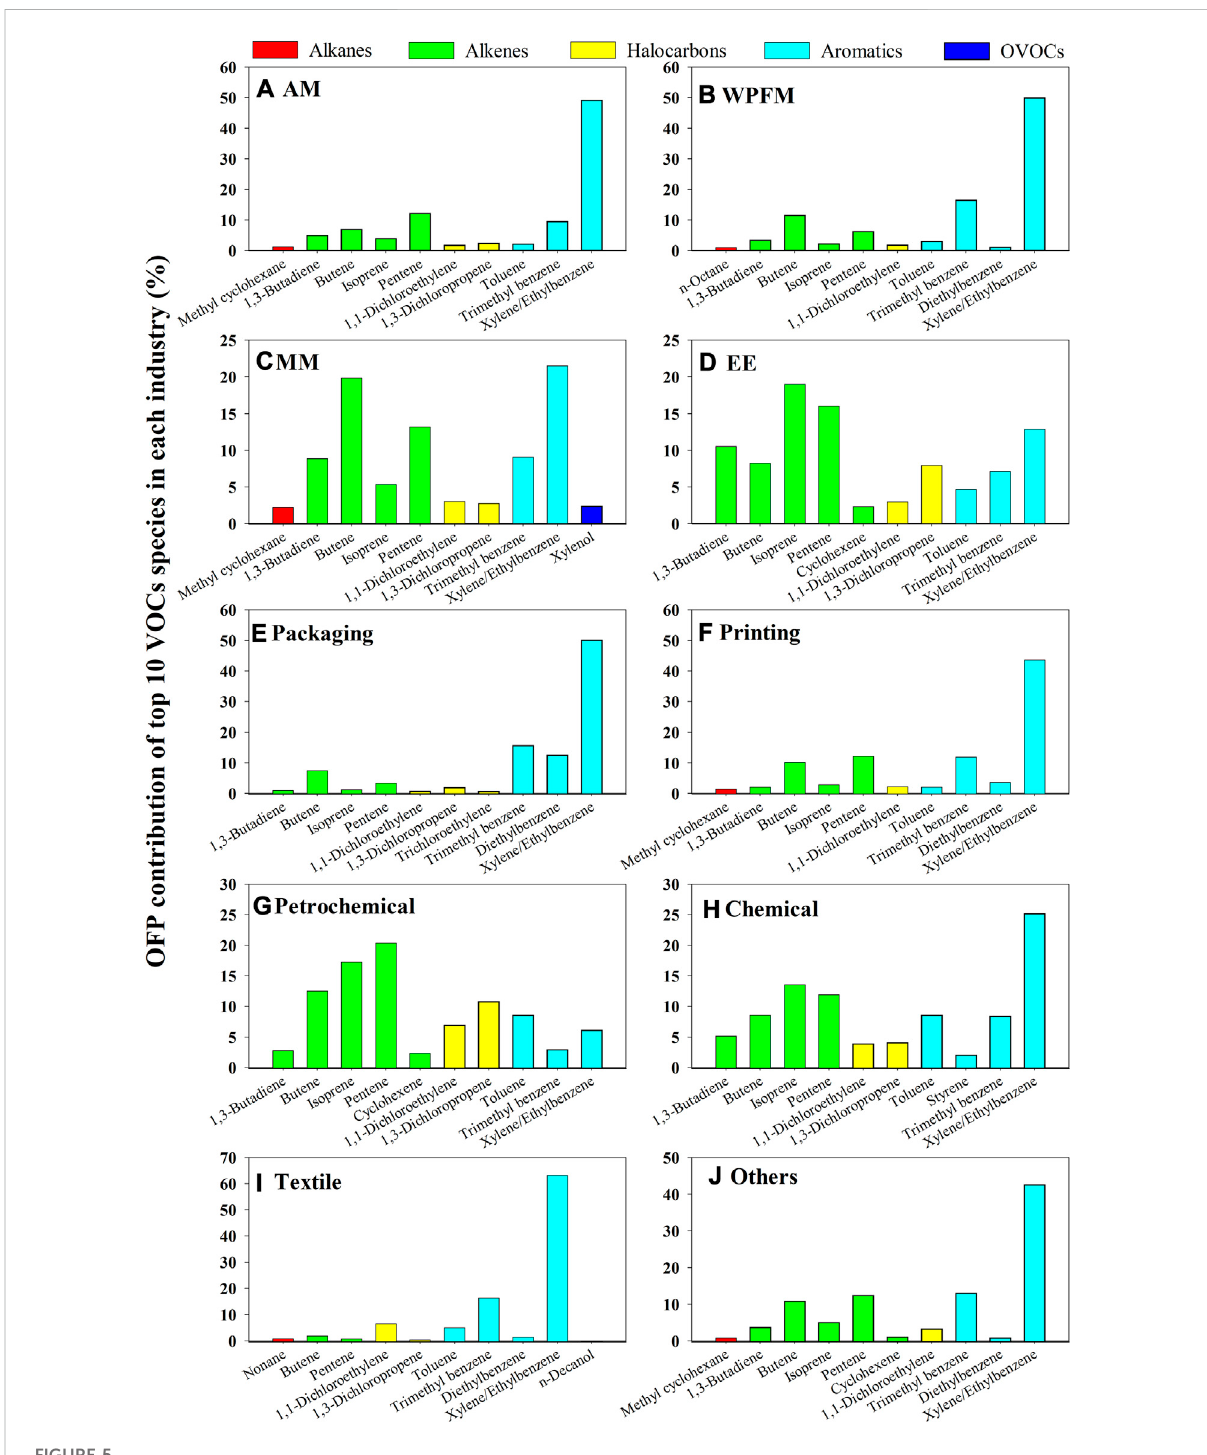
FIGURE 5 OFP contribution of top 10 VOC species in each